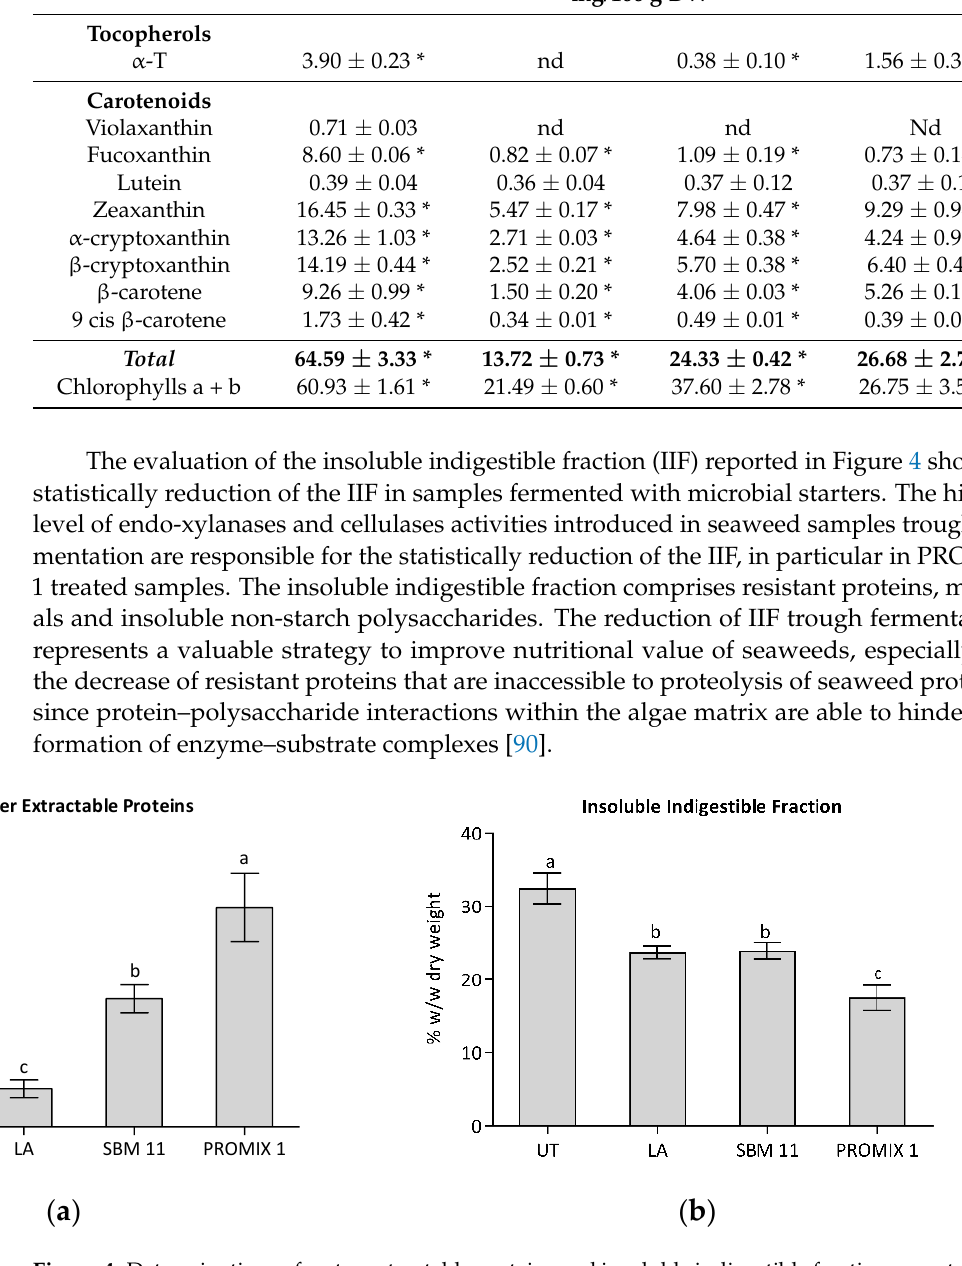
Figure 4. Determinations of water extractable proteins and insoluble indigestible fraction on untreated control (UT) and in fermented seaweed LA: Lactobacillus acidophilus ; SBM-11: a mix of Lactobacillus sakei , Staphylococcus carnosus and Staphylococcus xylosus ; PROMIX 1: Staphylococcus xylosus . Data were submitted to one- way analysis of variance (ANOVA), Tukey’s post hoc method was ap- plied to establish significant differences among samples ( p < 0.05).